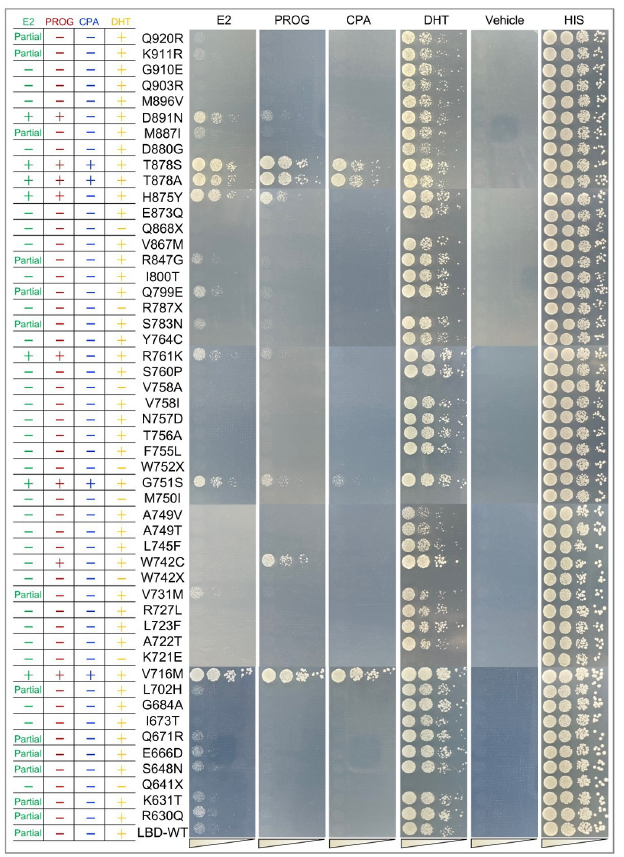
Fig 2. The functional analysis of 50 clinical AR mutants recorded in ARDB in response to steroidal ligands. The “+” mark indicates a full response of the AR mutants to indicated ligands was observed in plate yeast assays compared with LBD-WT, while the “–” mark indicates the opposite. The “Partial” mark indicated a partial ligand-induced response of the AR mutants. The concentration of all ligands in the yeast assay were 2 μ M. Plates were photographed 60 h after incubation. Thirteen mutants (R630Q, K631T, S648N, E666D, Q671R, L702H, V731M, S783N, Q799E, R847G, M887I, K911R and Q920R) behaved similarly to the wild type protein showing full response to the physiological ligand DHT and partial response to a high dose (2 μ M) of E2. Eight mutants (Q641X, K721E, W742X, M750I, W752X, V758A, R787X, Q868X) were identified as loss-of function mutations failed to respond to any tested steroids. Mutations ending in X like Q641X indicated that a stop-codon was generated in this position resulting in the expression of a truncated AR protein.